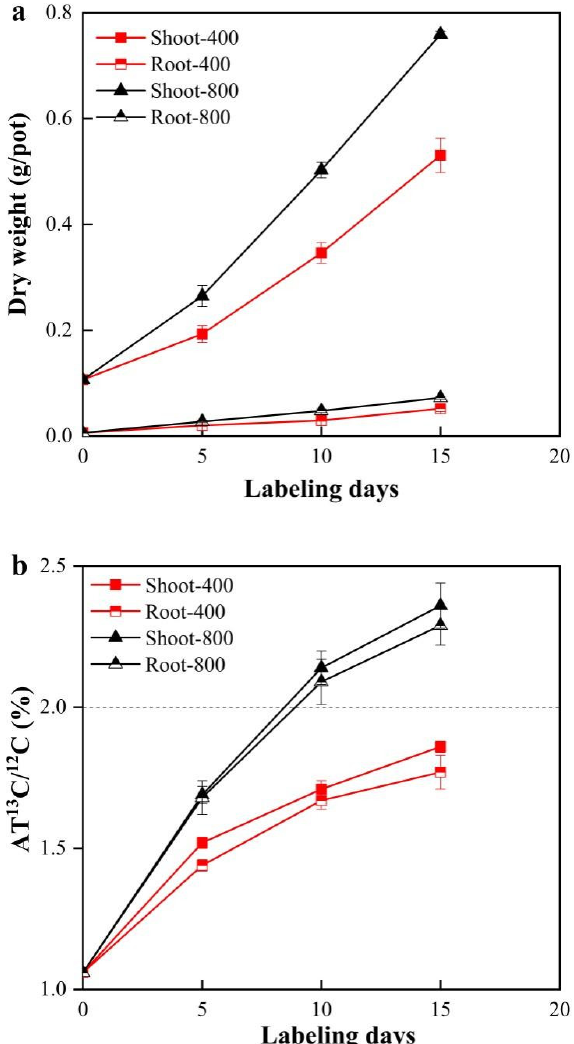
Figure 1. Changes in plant dry weights ( a ) and AT% 13 C/ 12 C values of shoots and roots ( b ) during the 15 labeling days. 400:400 µmol · mol −1 CO 2 treatment; 800:800 µmol · mol −1 CO 2 treatment. Bars represent the standard errors of the means (n = 4).